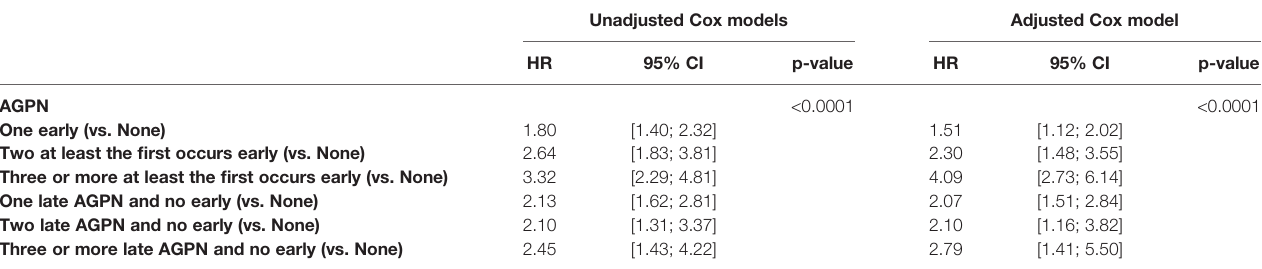
TABLE 4 | Results of the unadjusted (univariate) and multivariable cause-speci fi c time-dependent Cox models strati fi ed on center studying the risk of